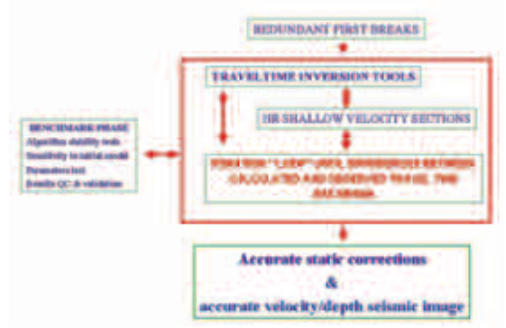
Fig. 6b. Near surface tomography processing